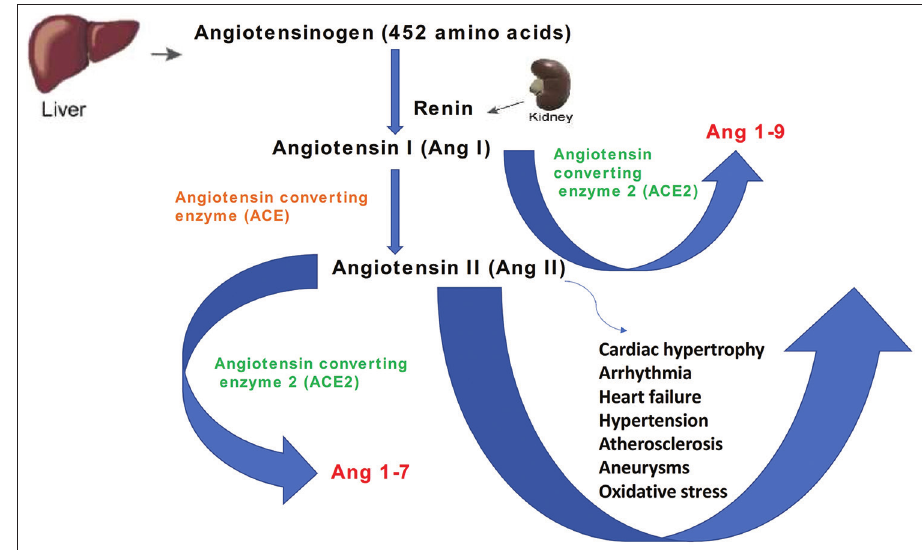
Figure-1: The components of renin-angiotensin system (RAS) and its involvement in the cardiovascular